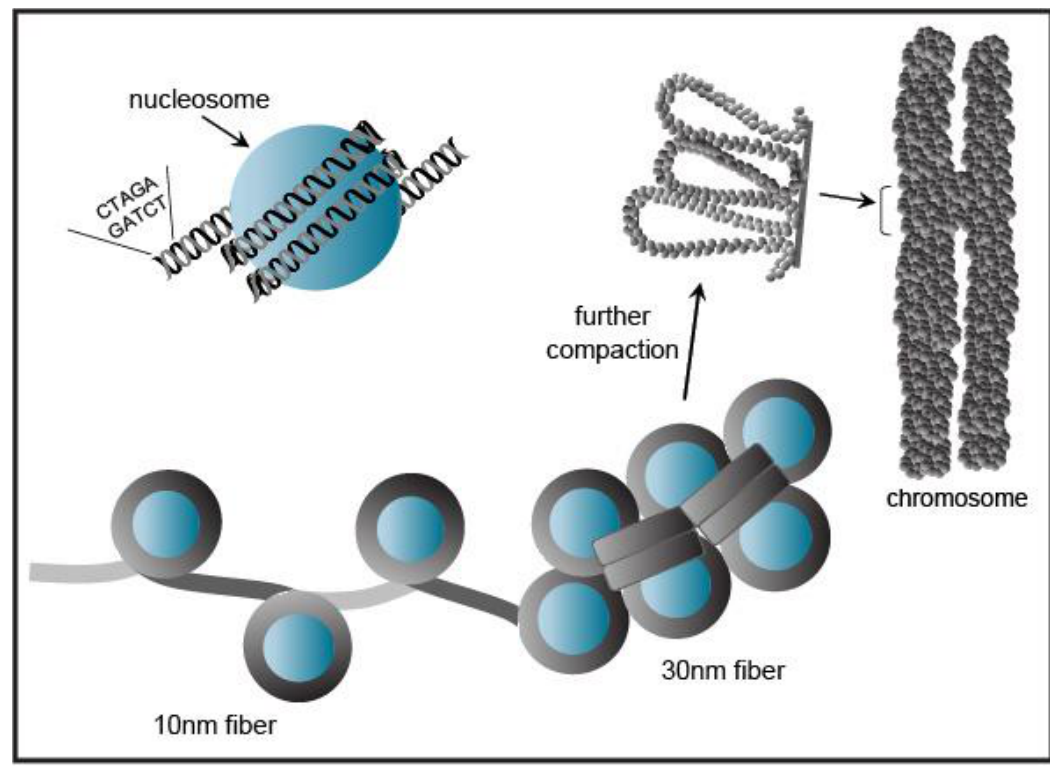
Figure 4. DNA is packaged into chromatin. About 80% of genomic DNA is packaged into nucleosomes, which consists of 146 base pairs of DNA wrapped around a histone octamer. The chromatin fibers adopt a “beads on a string” configuration with a diameter of 10 nm and may be further condensed into a compact 30 nm fiber. The chromatin is folded into a defined structure (as defined by the basic radial loop model) by chromatin remodeling enzymes during cell